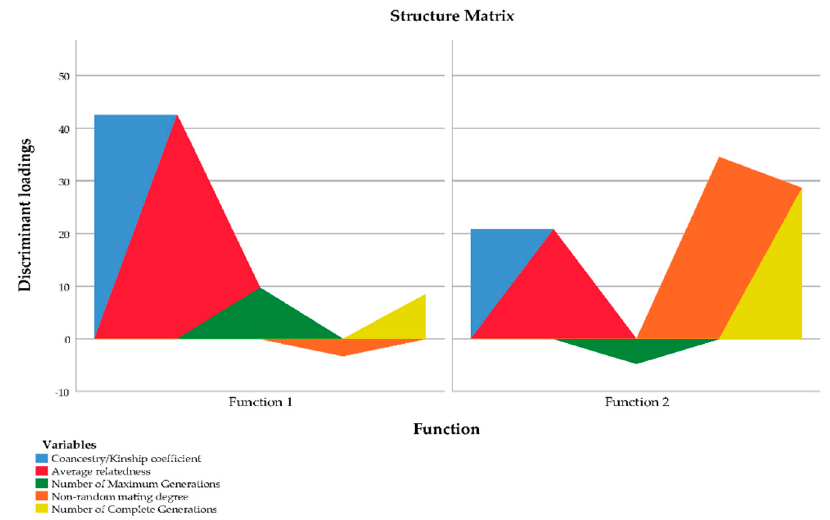
Figure 4. Vector plot of discriminant loadings for genetic diversity parameters.